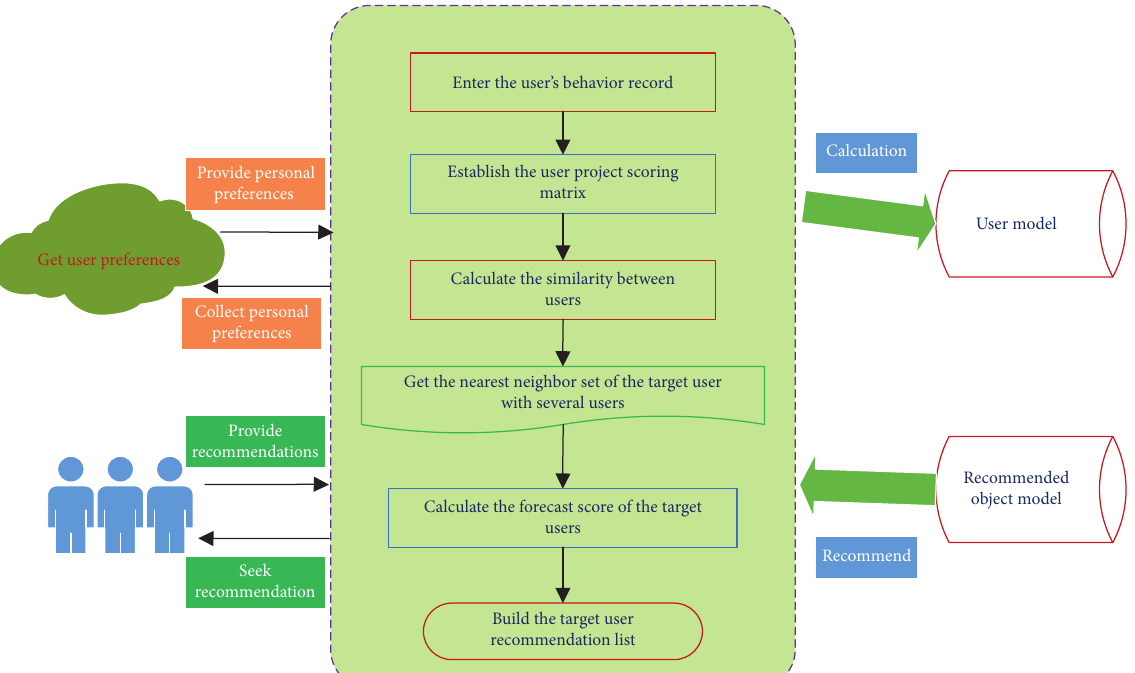
Figure 2: User collaborative filtering algorithm recommendation system